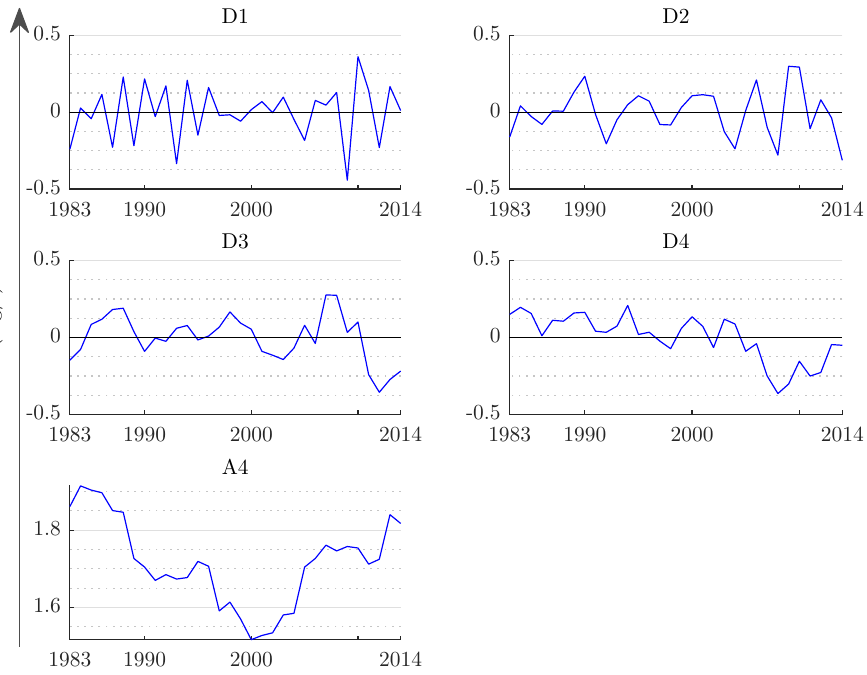
Figure 7. Detailed coefficients of (DW1) two years, (DW2) four years, (DW3) eight years, and (DW4) sixteen years along with the approximation coefficient (A4) of Besham Qila are